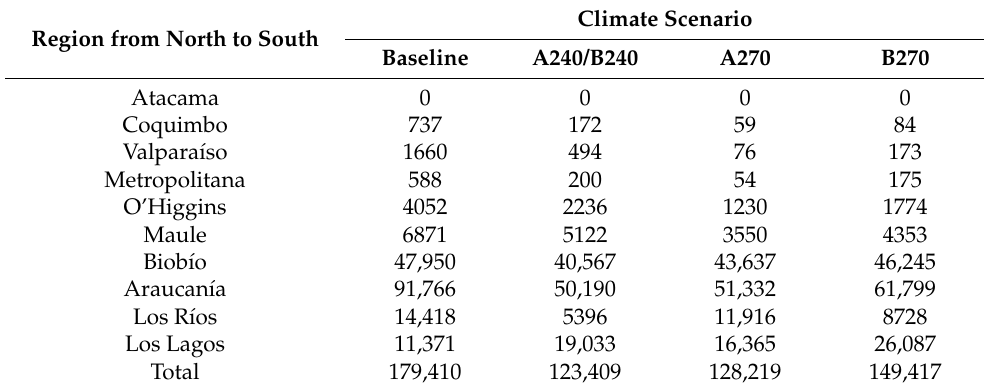
Table 4. Land area under rainfed wheat by region and climate-change scenario (hectares). Region from North to